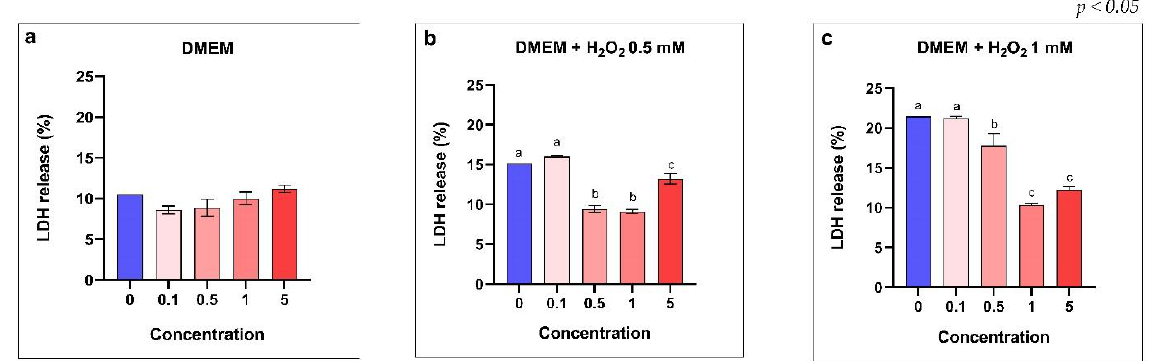
Figure 5. Membrane integrity of intestinal IPEC-J2 cells. ( a ) Dose − response curves with different concentrations of the combination of Ascophyllum nodosum and Lithotamnium calcareum; ( b ) Membrane integrity of IPEC-J2 cells challenged with H 2 O 2 0.5 mM and pre-treated with the combination of Ascophyllum nodosum and Lithotamnium calcareum; ( c ) Membrane integrity of IPEC-J2 cells challenged with H 2 O 2 1 mM and pre-treated with the combination of Ascophyllum nodosum and Lithotamnium calcareum. Data are shown as means and standard deviations. a–c Means ( n = 3) with different superscripts are significantly different (Treatment p < 0.05).